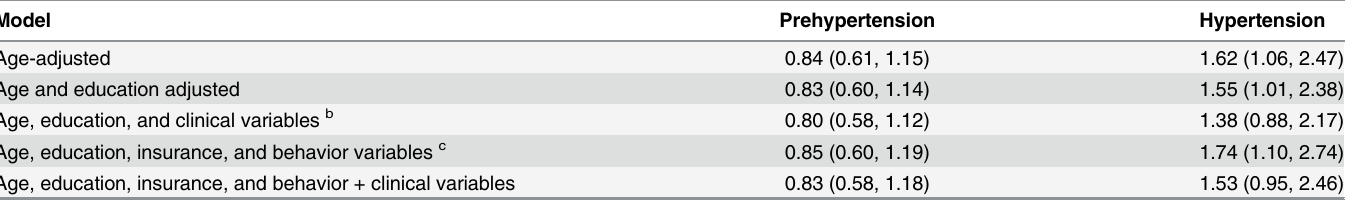
Table 3. Association of Baseline Depression a and Incident Prehypertension and Hypertension at Year 3 in Women who were Normotensive at Baseline.